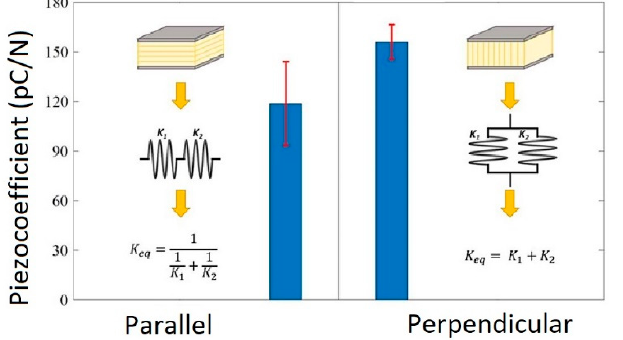
Figure 22. Comparison of piezoelectric coefficients and standard deviation between sample orien- tations (Reprinted from Ref. [102], copyright (2019), with the kind permission of IOP Publishing Ltd.).